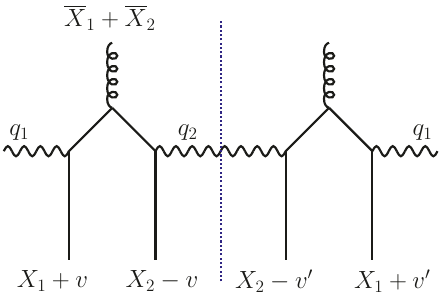
Figure 7 . Lowest order graph for the 2v1 mechanism, with the blobs connecting partons with hadrons being omitted at the top and the bottom. The vector boson with momentum q 1 is under- stood to cross the final state cut. The four quark lines at the bottom are right moving, the two gluons entering at the top left